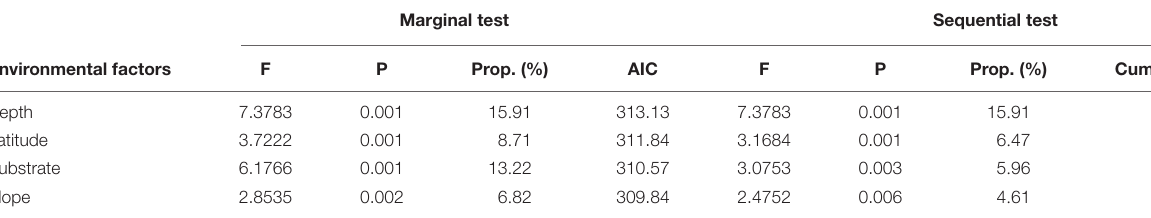
TABLE 5 | Results of DistLM analyses on megafaunal community and environmental factors.